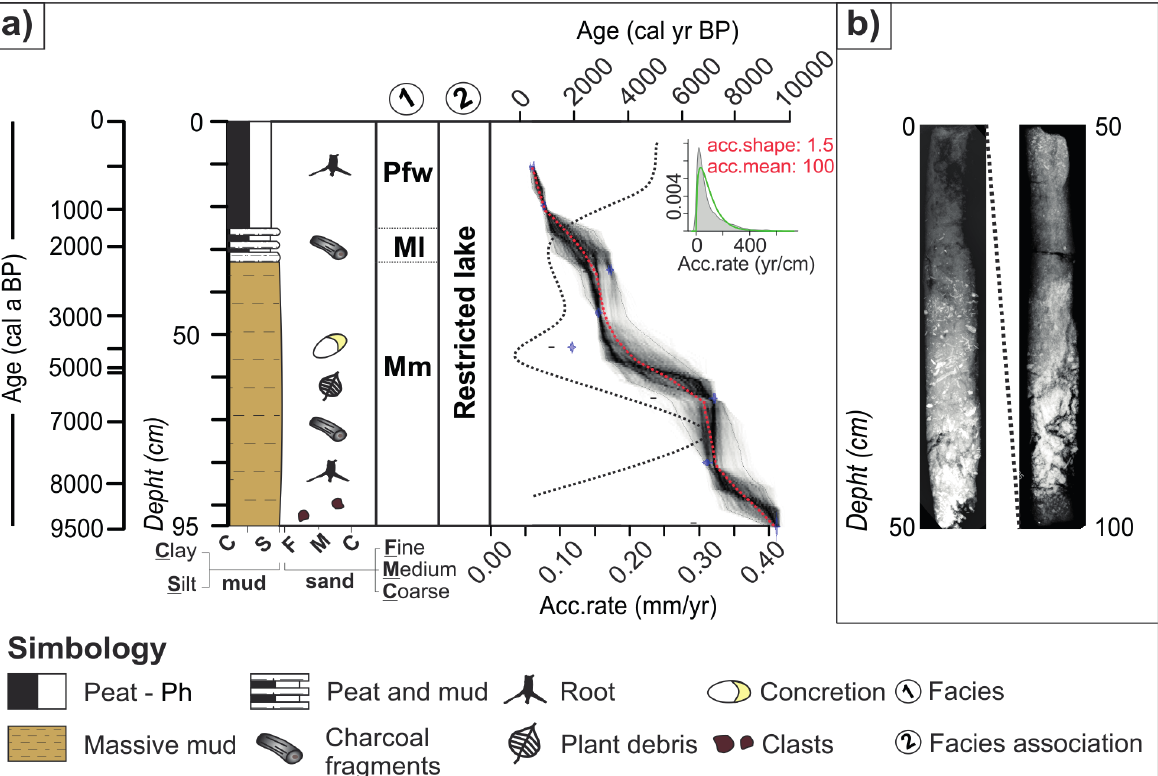
Figure 2 - Lithostratigraphic profiles illustrating facies characteristics and facies succession in R4 core (95 cm) collected from the Serra Sul de Carajás. The profile includes calibrated 14 C dates (transparent blue), age–depth model (darker greys indicate more likely calendar ages; grey stippled lines show 95% confidence intervals; red curve shows single ‘best’ model based on the weighted mean age for each depth) and sedimentation rates (mm/yr) along the depth profile based on weighted mean age for each depth. The small box in the upper right corner of each age–depth model: green curve is the accumulation rate (prior) and the grey shading is the modelled accumulation rate (posterior).